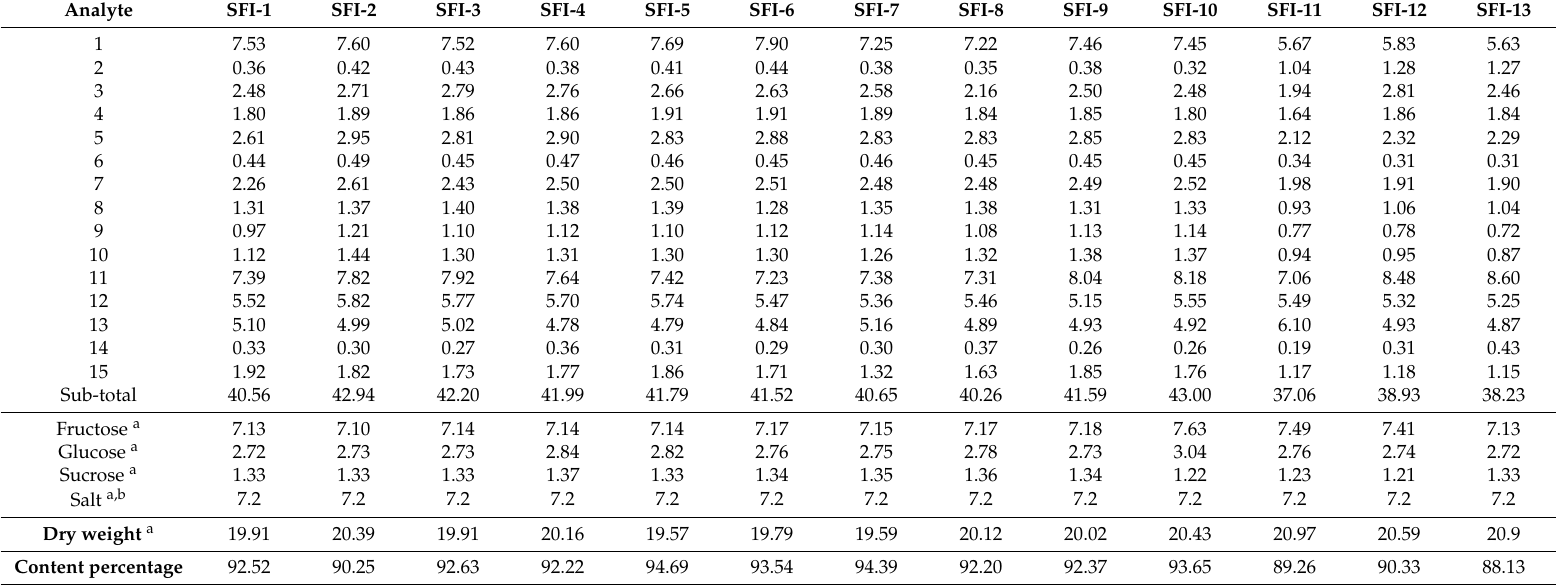
Table 3. The contents ( µ g/mL) of 18 analytes in 13 SFI